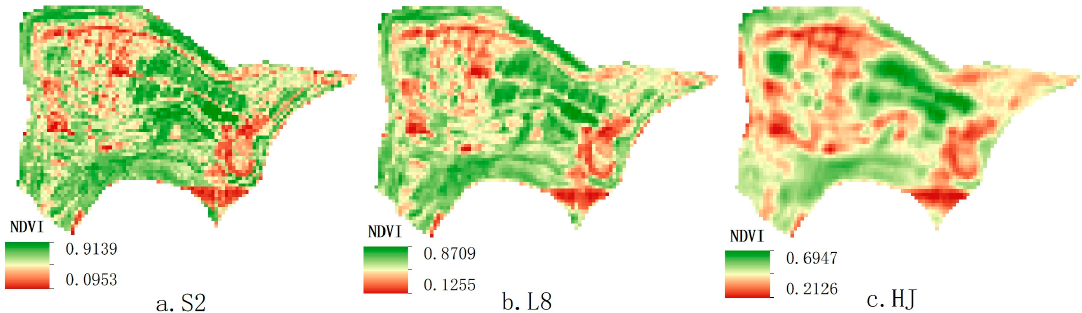
Figure 7. NDVI monitored by different satellite sensors in the West Expansion Dump (( a ): NDVI caculated from Sentinel-2(S2); ( b ): NDVI caculated from Landsat 8(L8); ( c ): NDVI caculated from HJ).